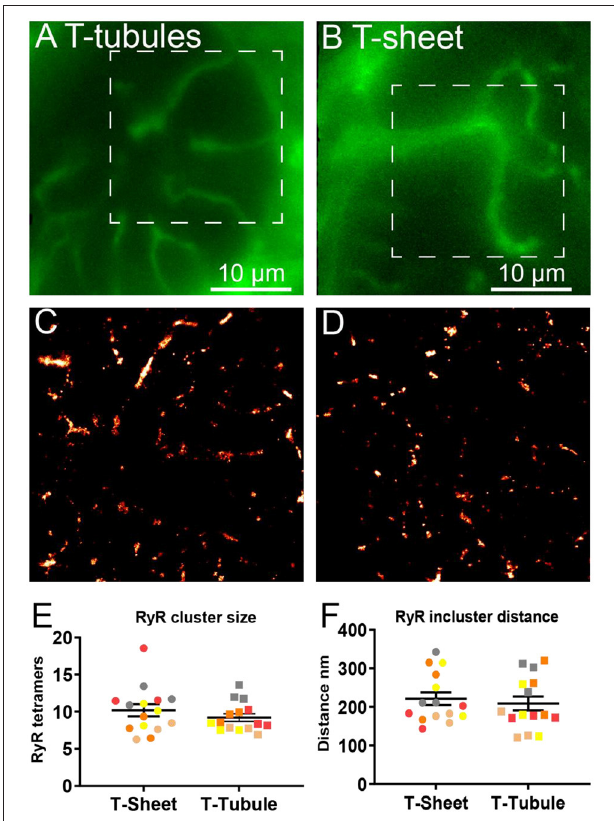
FIGURE 7 | Comparison of RyR clusters between t-tubules and t-sheets regions in IDCM human hearts. (A) Epifluorescence image of WGA labelled t-tubules recorded on super-resolution microscope before subsequent nanoscale imaging of RyR clusters. (B) Epifluorescence image of WGA labelled t-sheet recorded on super-resolution microscope before subsequent nanoscale imaging of RyR clusters. The t-sheet identification was confirmed by changing the focus by several microns and the structure designated a t-sheet if it was visible throughout the change in focus. (C) Super-resolution image of RyR clusters from t-tubular region recorded from the white box in “ (A) ”. (D) Super-resolution image of RyR clusters from t-sheet region recorded from the white box in “ (B) ”. (E) Mean RyR cluster size in the t-tubule and t-sheet regions. (F) Mean RyR cluster nearest neighbour distance in the t-tubule and t-sheet regions. Five IDCM hearts were analysed with 3 t-tubule and 3 t-sheet regions imaged from each heart. LME model was used to test for effects of the region (t-sheets and t-tubules) and random effects were in the heart. For RyR cluster size p = 0.53 and for RyR cluster nearest neighbour p = 0.19. Symbols of the same colour in “ (E,F) ” are from the same